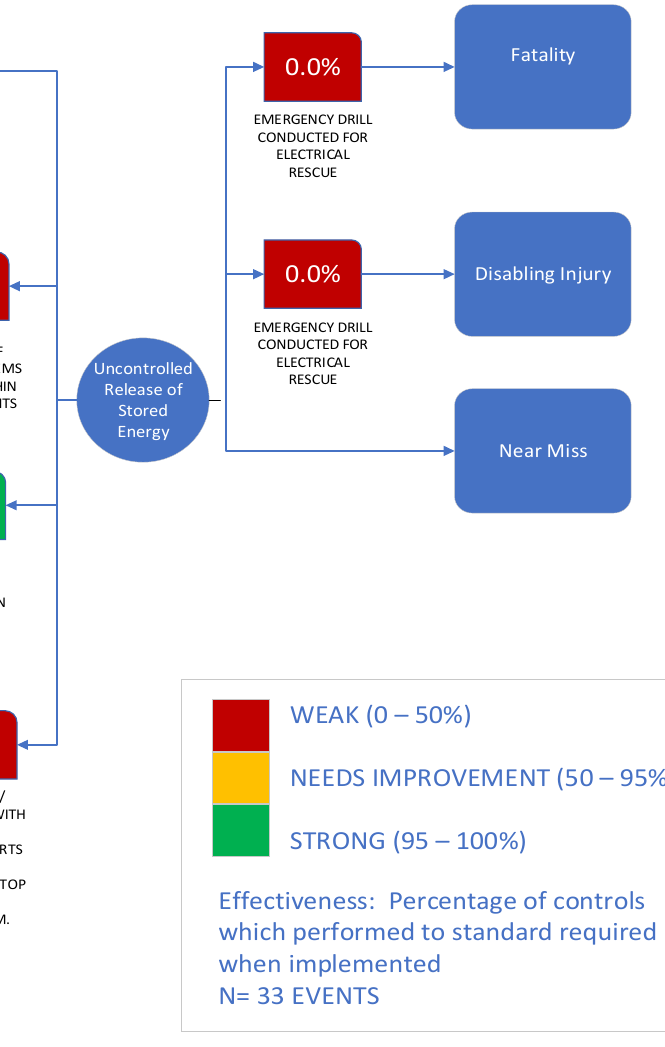
Figure 10. Stored Energy—Critical Control Reliability.